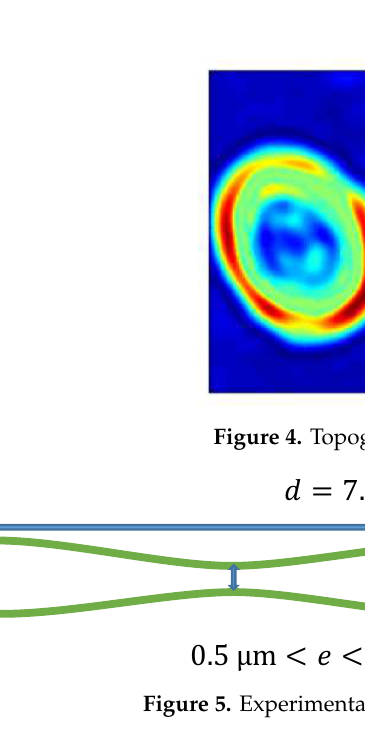
Figure 8. Recorded images of infected cell D at the schizont stage, at the wavelength λ = 800 nm for different z planes ( a )–( c ), its corresponding refractive index distribution ( d )–( f ) and hemoglobin content ( g )–( i ). The selected images are representative of a total of 33 cells analyzed.